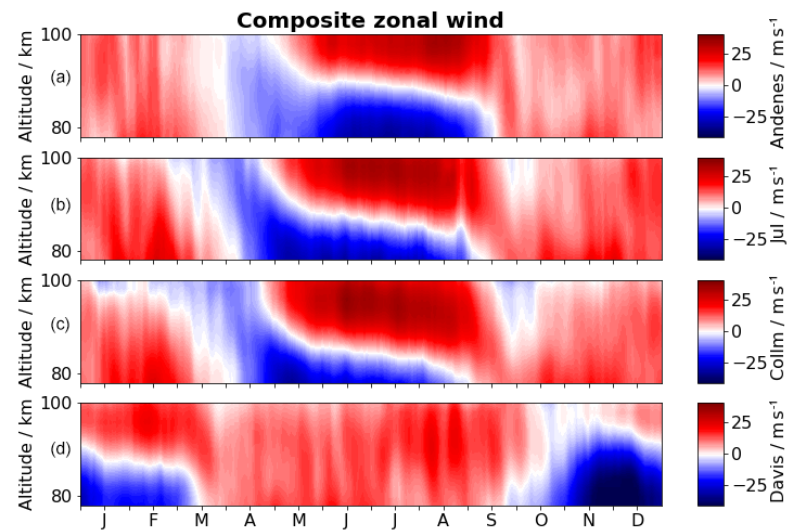
Figure 2. Composites of zonal wind for the Northern Hemisphere stations Andenes (a) , Juliusruh (b) , and Collm (c) . (d) shows the southern- hemispheric station of Davis. The composite for Andenes, Collm, and Davis includes 12 years of meteor radar data and that of Juliusruh includes 9 years. Positive values correspond to eastward-directed winds and negative to westward-directed winds.